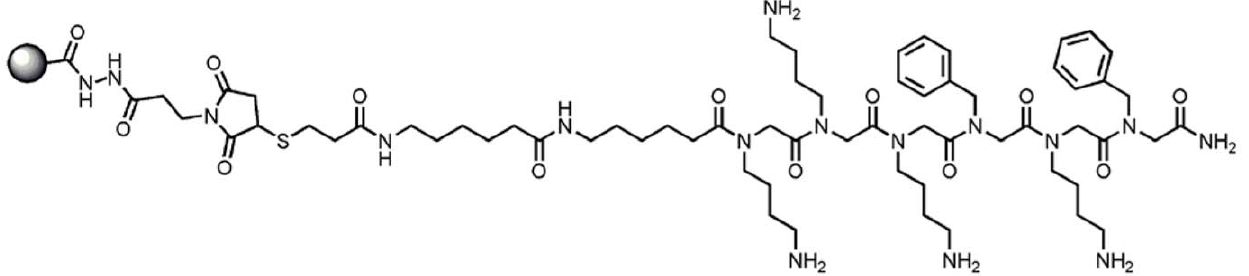
Figure 1. Aggregate Specific Reagent 1 (ASR1). Chemical structure of ASR1 peptoid conjugated to a solid surface.